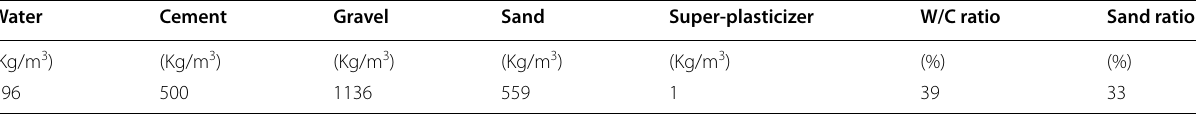
Table 3 Concrete mix